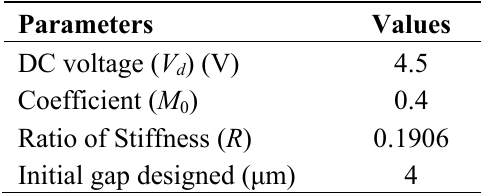
Table 1. Parameters of the accelerometer